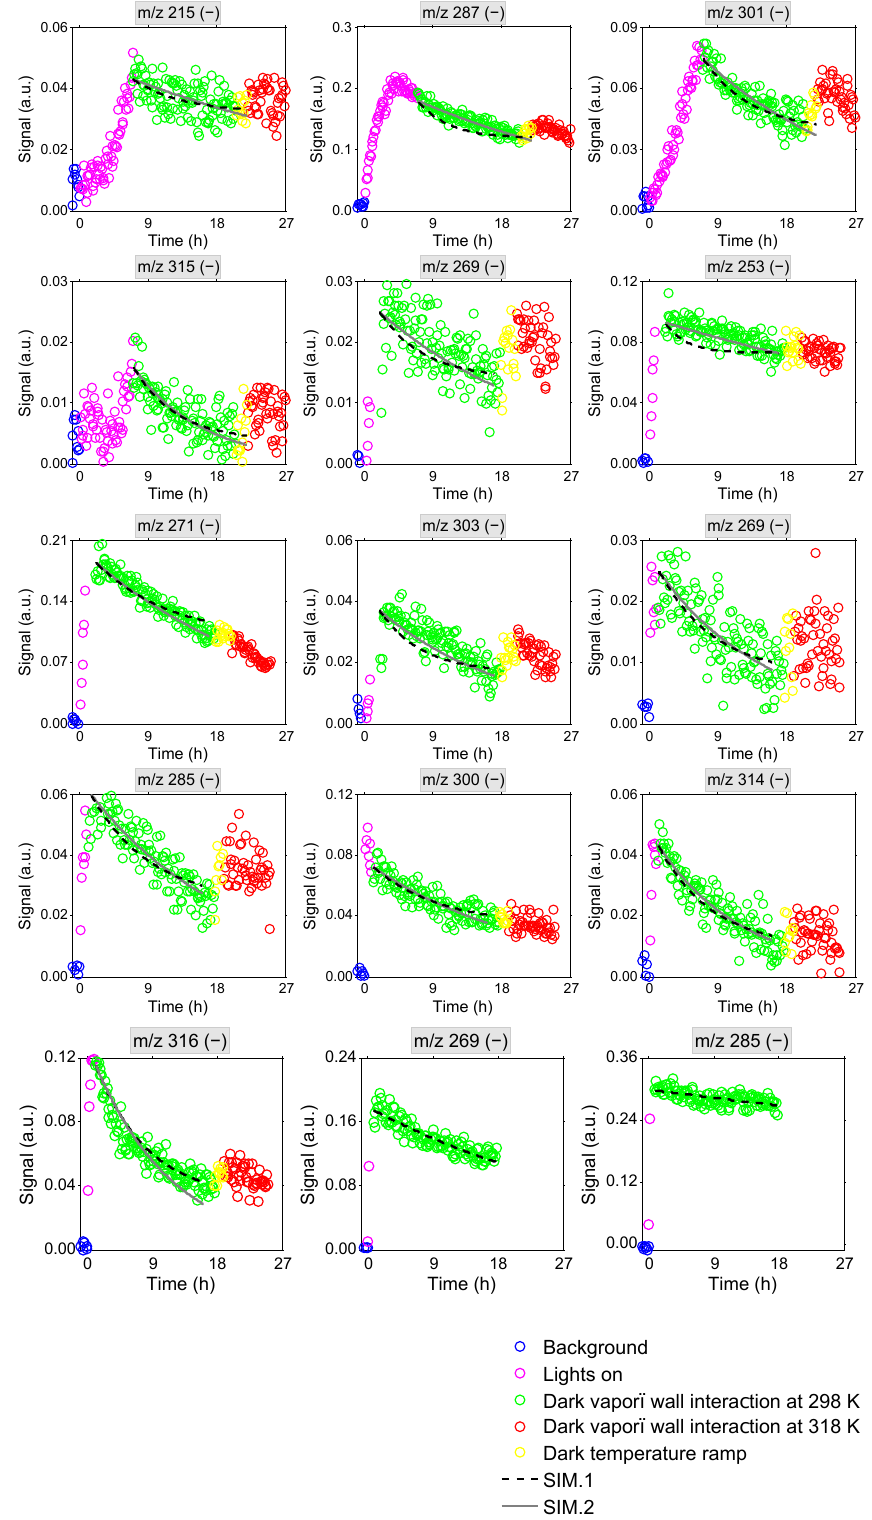
Figure 3. CIMS traces of oxidized organic vapors generated from the photooxidation of isoprene, toluene, α -pinene and dodecane under high/low-NO conditions over the four chamber periods in Fig. 2. Colored circles represent CIMS measured normalized signals during background (blue), vapor generation (magenta), vapor wall deposition at 298K (green), temperature ramp (yellow), and vapor re-evaporation at 318K (red). Black dashed lines and gray solid lines represent the simulated deposition rates generated from SIM.1 and SIM.2,